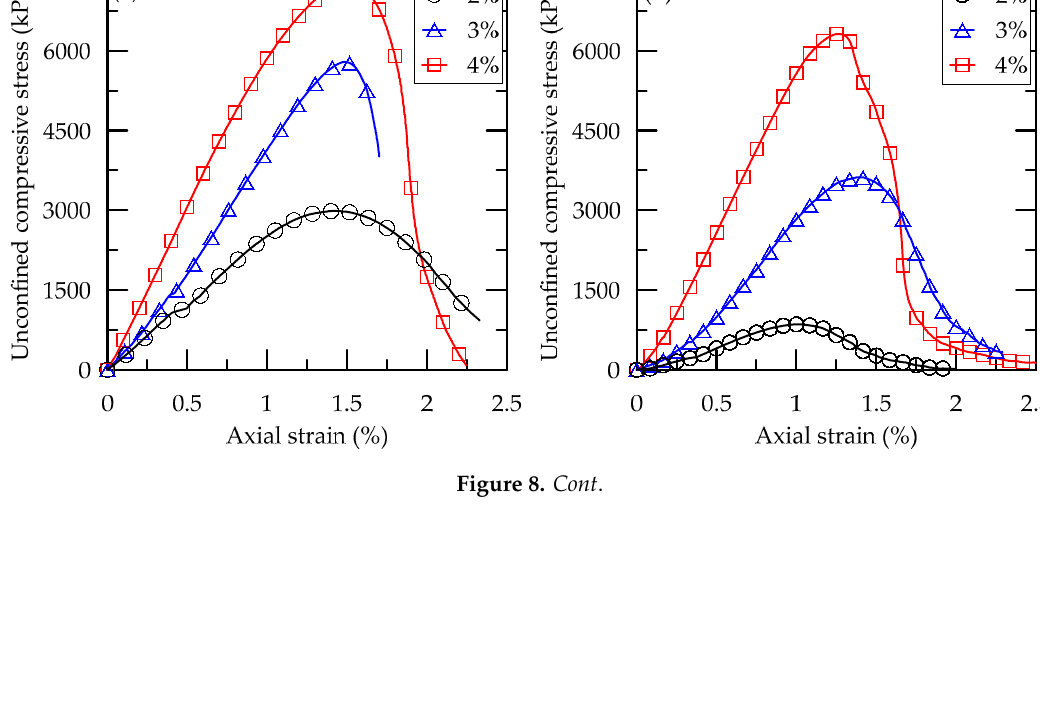
Figure 8. Stress-Strain relationship of casein and/or slag cemented ( a ) STD, ( b ) MOD, and ( c ) MBS samples.